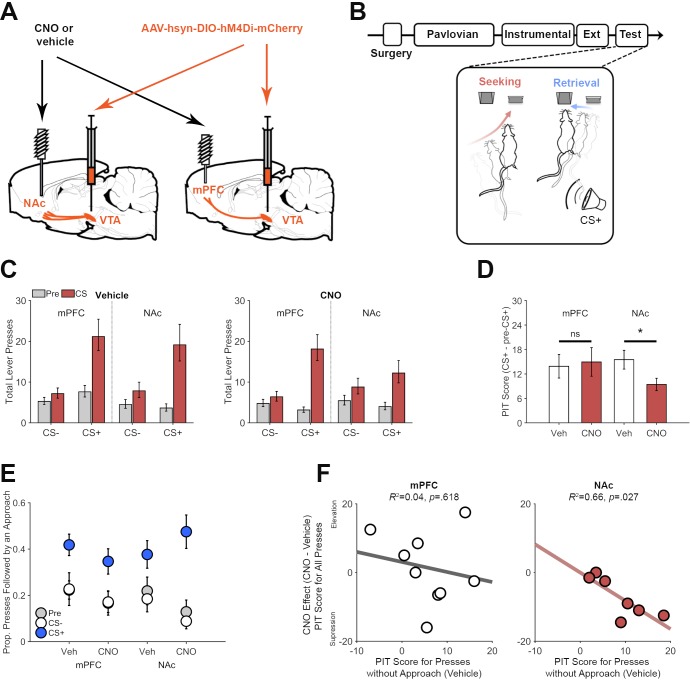
Pathway specific chemogenetic inhibition of dopamine on PIT performance.(A) Th:Cre+ rats initially received VTA AAV-hSyn-DIO-hM4Di-mCherry injections and were implanted with guide cannulas aimed at the medial prefrontal cortex (mPFC) or nucleus accumbens (NAc) for microinjection of CNO (1 mM) or vehicle to inhibit dopamine terminals at test. (B) Following surgery, rats underwent training and testing for PIT, as described above. We analyzed the microstructural organization of behavior (Lever presses: seeking, and presses followed by a food-cup approach: retrieval) at test. (C) Pathway specific inhibition of dopamine terminals in the NAc but not the mPFC disrupted cue-motivated reward seeking. Total lever presses during PIT trials for rats expressing the inhibitory DREADD hM4Di and receiving CNO or vehicle microinfusions in either the mPFC or NAc prior to test. Presses during pre-CS (gray) and CS periods (red) are plotted separately. (D) PIT expression was specifically impaired following NAc CNO treatment. PIT scores (total presses: CS+ - pre-CS+) show that the CS+ increased lever pressing following vehicle treatment in both groups, but that CNO suppressed this effect when injected into the NAc but not the mPFC. *p<0.05. (E) The CS+ increased the proportion of lever presses that were followed by a food-cup approach during PIT testing. This effect did not significantly vary as a function of drug treatment or group. (F) Scatter plots show the relationship between individual differences in the effect of the CS+ on lever presses that were not followed by food-cup approach in the vehicle condition (PIT Score for presses without approach) and the suppressive effect of CNO on CS+ evoked lever pressing (PIT Score for CNO test - PIT Score for vehicle test). Data points are from individual rats receiving intra-mPFC (left panel) or intra-NAc (right panel) microinjections.10.7554/eLife.43551.016Figure 4—source data 1.This spreadsheet contains the behavioral responses for individual rats in Figure 4.